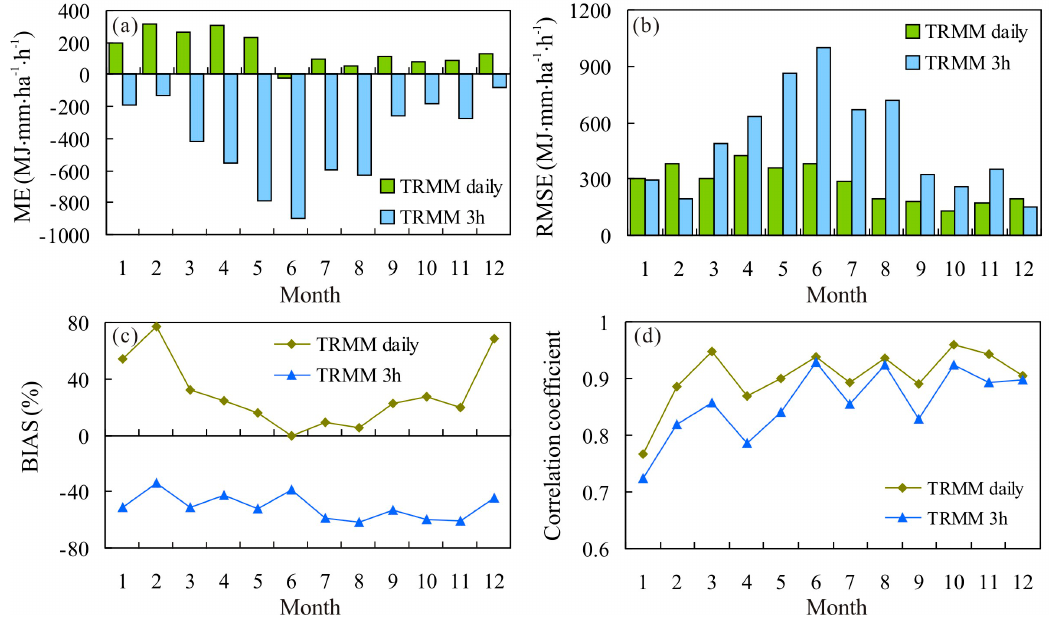
Figure 4. Monthly changes in ( a ) the mean error (ME), ( b ) the root mean squared error (RMSE), ( c ) the relative bias (BIAS) and ( d ) the correlation coefficient (R). Table 1. Seasonal changes in bias between Tropical Rainfall Measuring Mission products (TRMM) and rain gauges data.